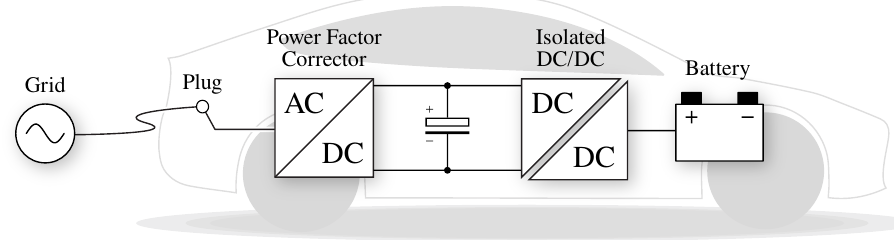
Figure 1. Schematic overview of a typical EV on-board